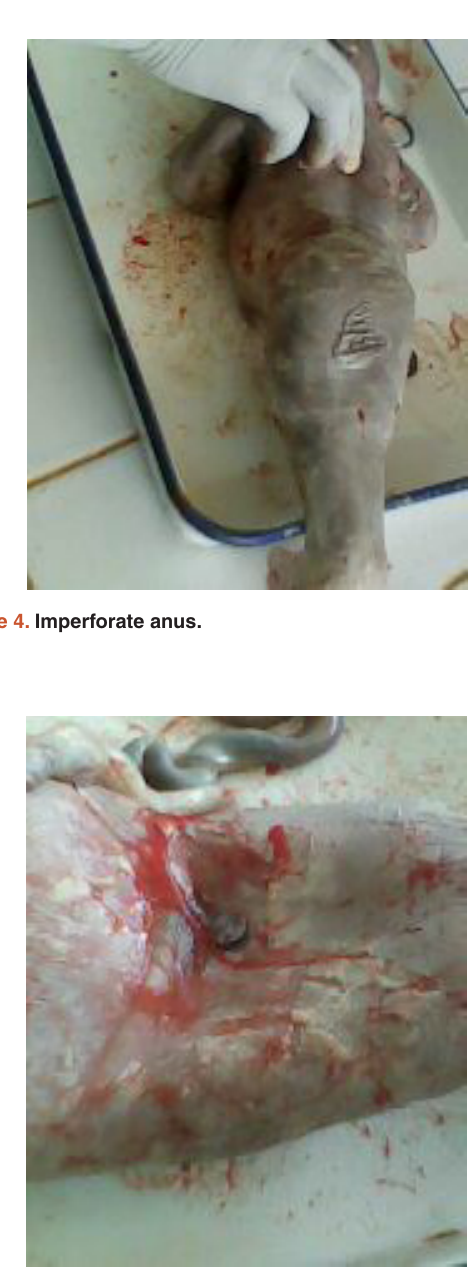
Figure 3. Posterior view showing fused lower limbs, imperforate anus.